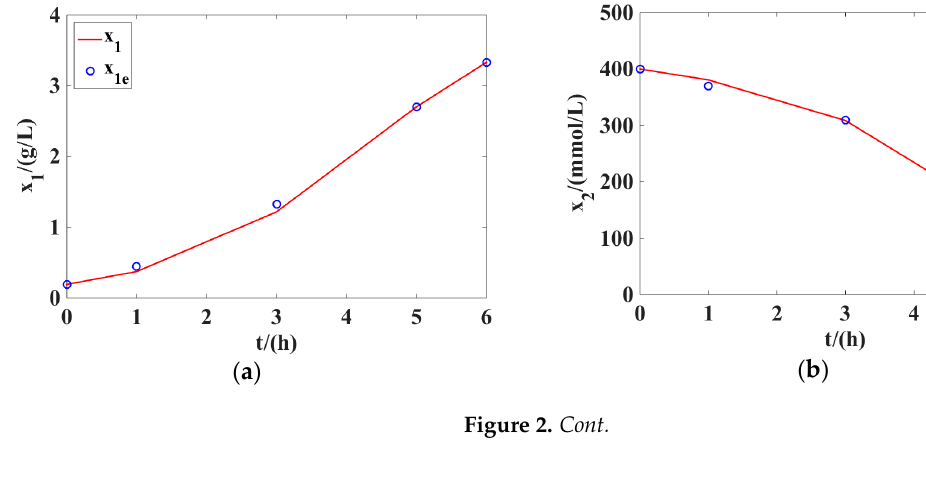
Table 3. Comparison between the proposed two-stage method and the single-stage approach from Reference [17].